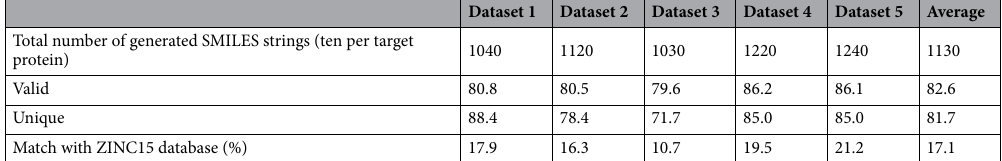
Dataset 1 Dataset 2 Dataset 3 Dataset 4 Dataset 5